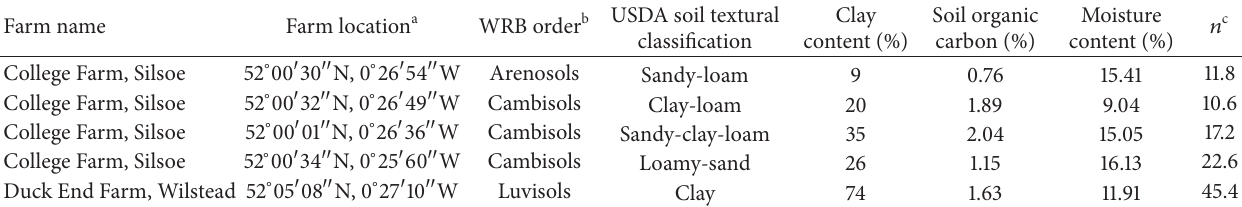
Table 1: Sampling sites and background amount of selected soil